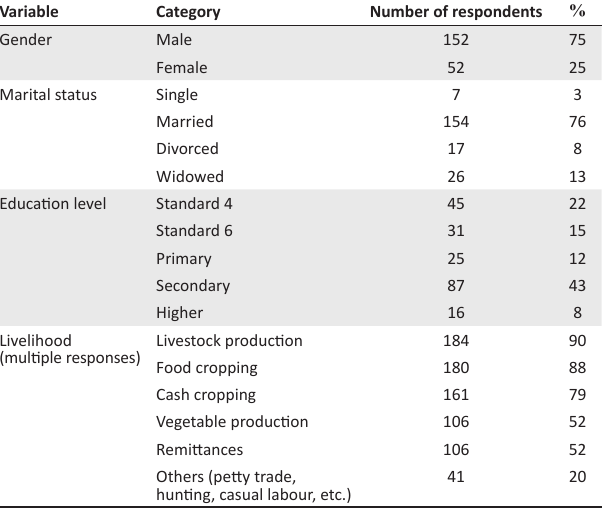
TABLE 1: Demographic, knowledge and perception responses of respondents. Variable